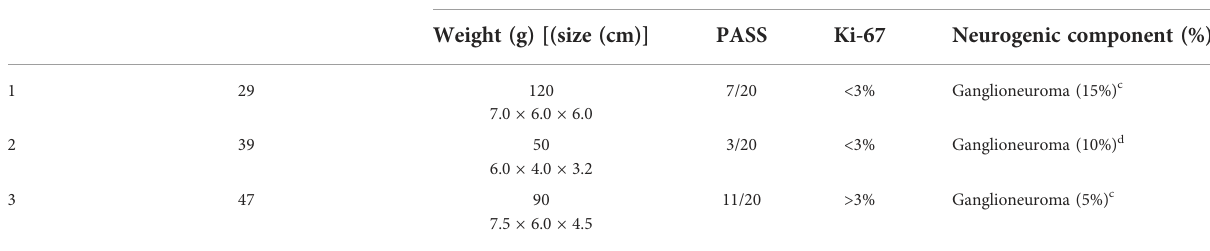
PCC, pheochromocytoma. a All cases had positive immunohistochemistry (IHC) to chromogranin (CgA) at the cytoplasm of PCC cells and to neuro fi lament (NF) in the cytoplasm of neuronal cells (aggregated or diffuse presentation). b IHC of S100 protein was positive in sustentacular cells of PCC as well as in Schwann cells from ganglioneuroma. c It was present in the middle of cystic and hemorrhagic areas of the tumor. d It was present as a peripheral ridge in the tumor of case 2.